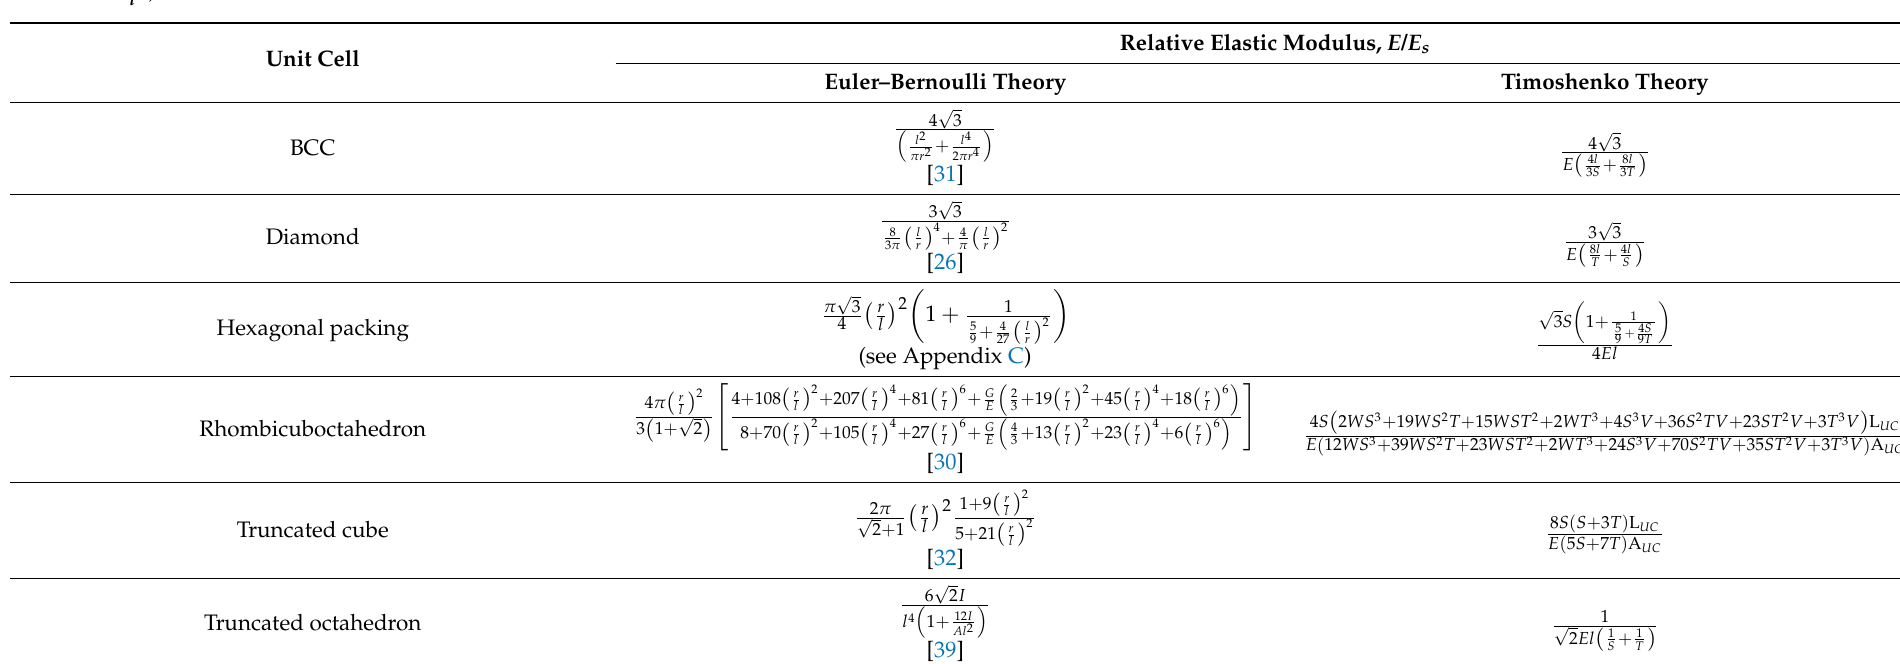
Table 2. Normalized elastic modulus relationships based on Euler–Bernoulli and Timoshenko beam theories for different unit cell types ( S = AE s W = G s J l